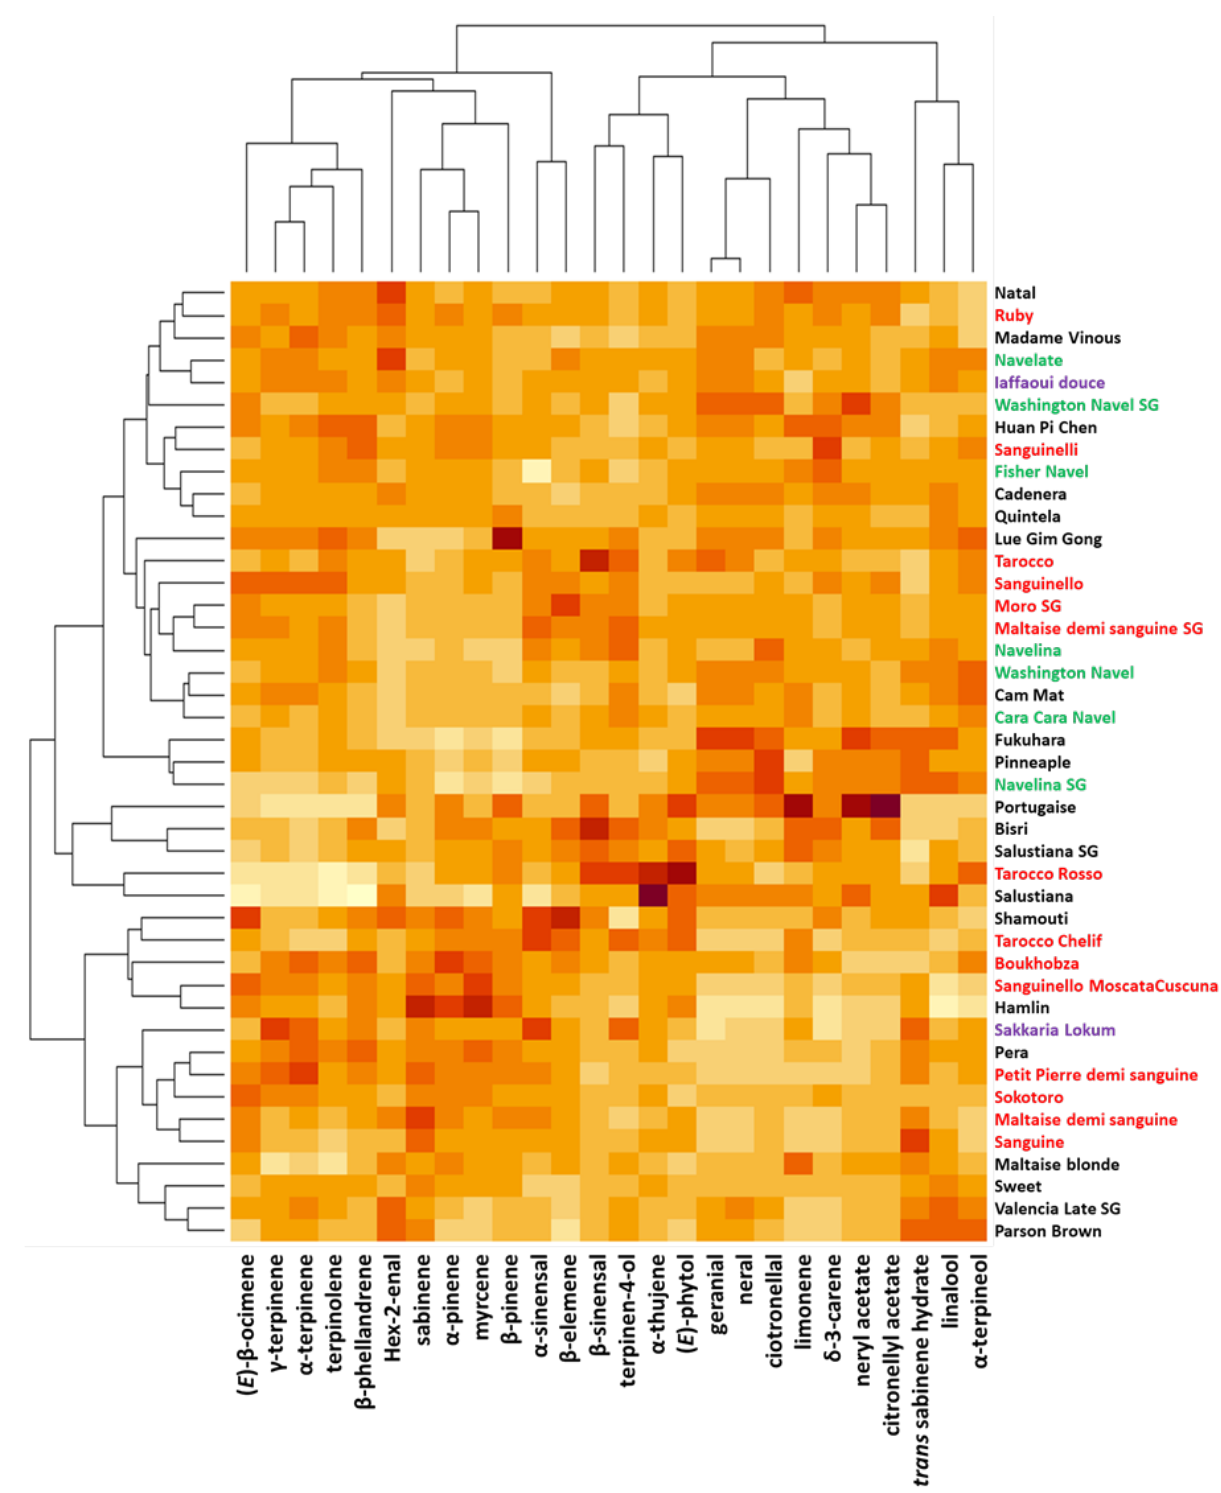
Figure 3. A heatmap representing the diversity of the 43 orange cultivars based on their composition of the 26 major leaf oil compounds. The color range from yellow to dark red indicates the degree of the observed trait value in the orange population. Bloody cultivars are represented in red, navels in green, acid-free in purple, and classic (blond) cultivars in black.